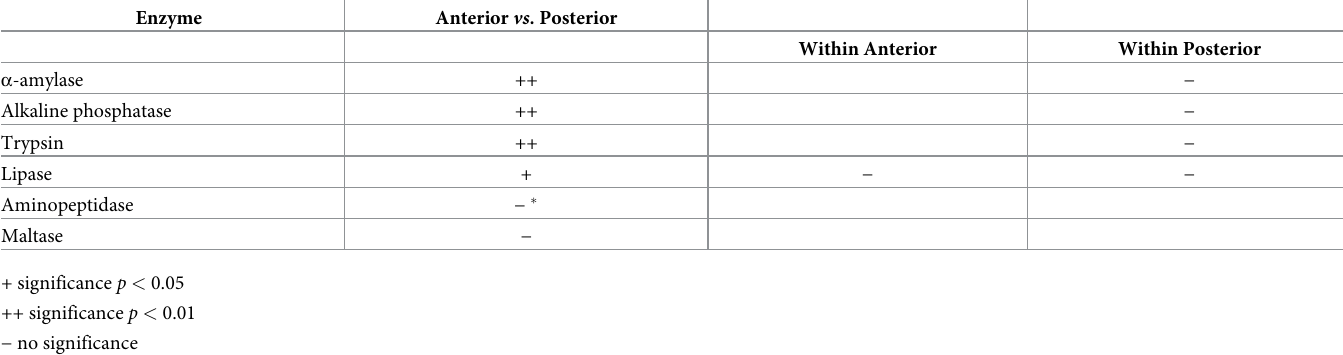
Table 1. Summary table depicting statistical relationships for the localization of α - amylase, maltase, lipase, trypsin, aminopeptidase, and alkaline phosphatase tis- sue activities in the Pacific hagfish alimentary canal. Enzyme Anterior vs . Posterior